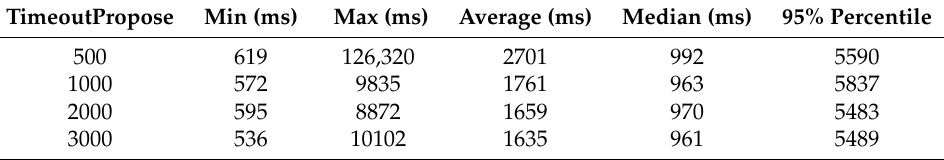
Table 7. Network latency with 8 producer nodes under failure assumption.